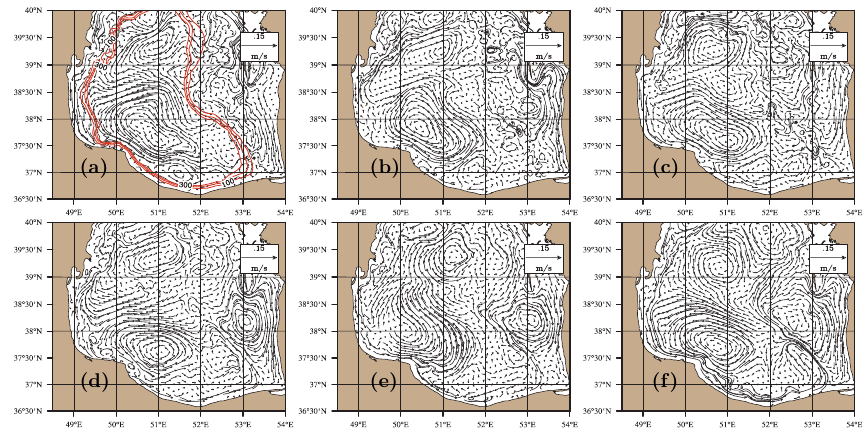
Figure 8. The evolution of the surface flow field in the SCS on 13 July, 12 August and 11 September (upper panels) and 11 October, 10 November and 10 December (lower panels); the red line in the first figure shows the 100, 200 and 300m bathymetry contour.